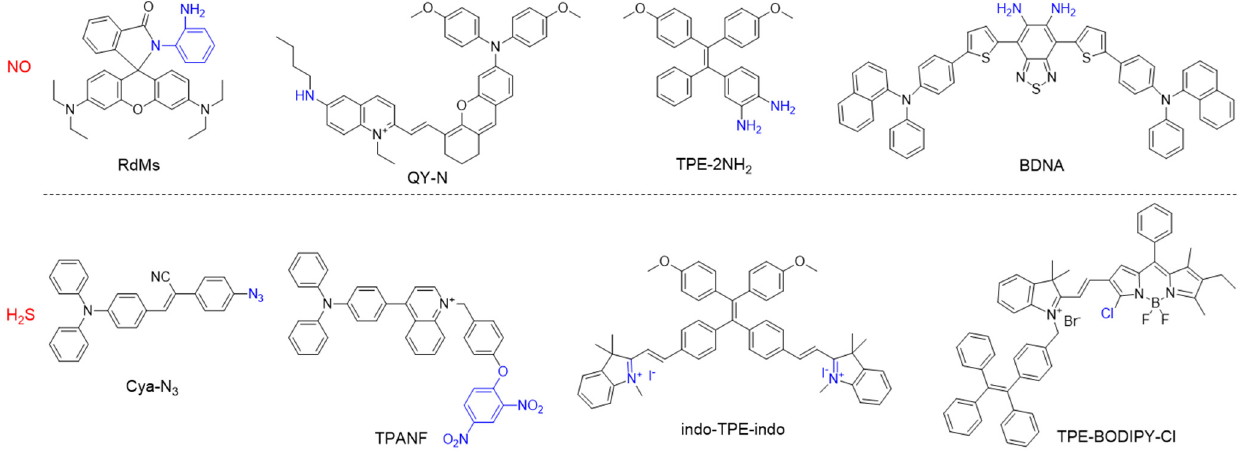
Figure 13. Chemical structures of different types of gasotransmitter-responsive molecular